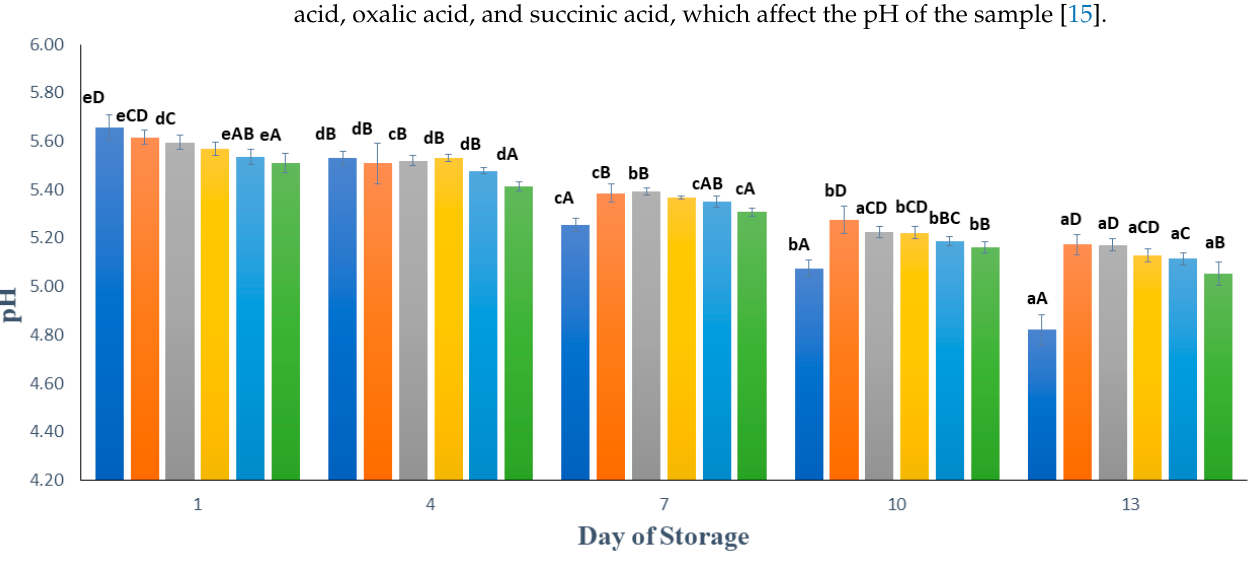
Figure 6. Effect of edible coating of gelatin composite enriched with black tea extract on the color (b*) of minimally processed watermelon during storage. The value shown is the average of the three experimental replications. A–E Values followed by the same capital letters showed no significant dif- ference ( p > 0.05) between treatments on the same day. a–e Values followed by the same non-capital letters showed no significant difference ( p > 0.05) between storage times in the same treatment.